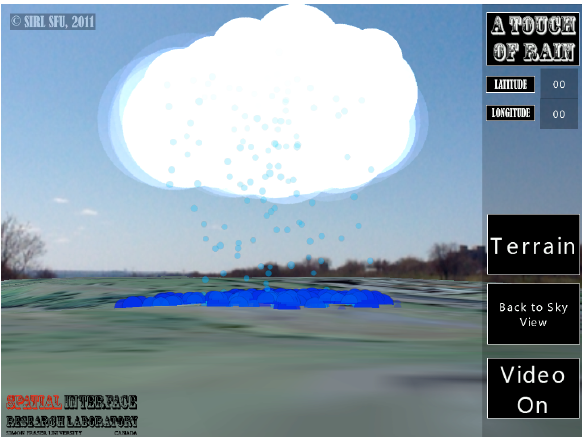
Figure 8. A live screen capture from An Augmented Touch of Rain . The virtual skybox has been toggled off, allowing the user to look around them in the real world through the tablet device and see the virtual clouds that they created.